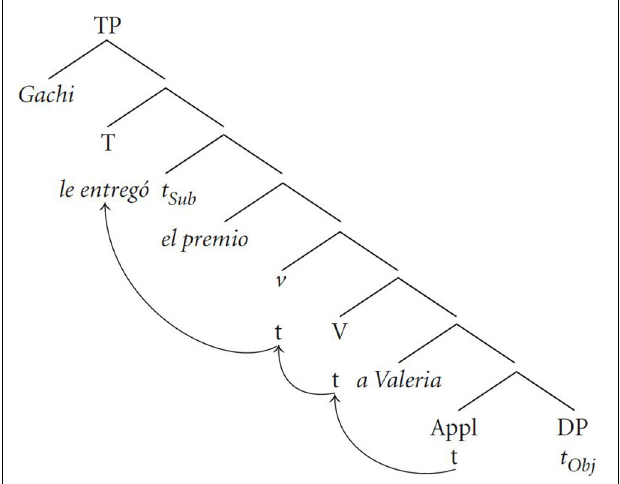
FIGURE 1 | Syntactic structure for Spanish double object constructions (Cuervo, 2003: